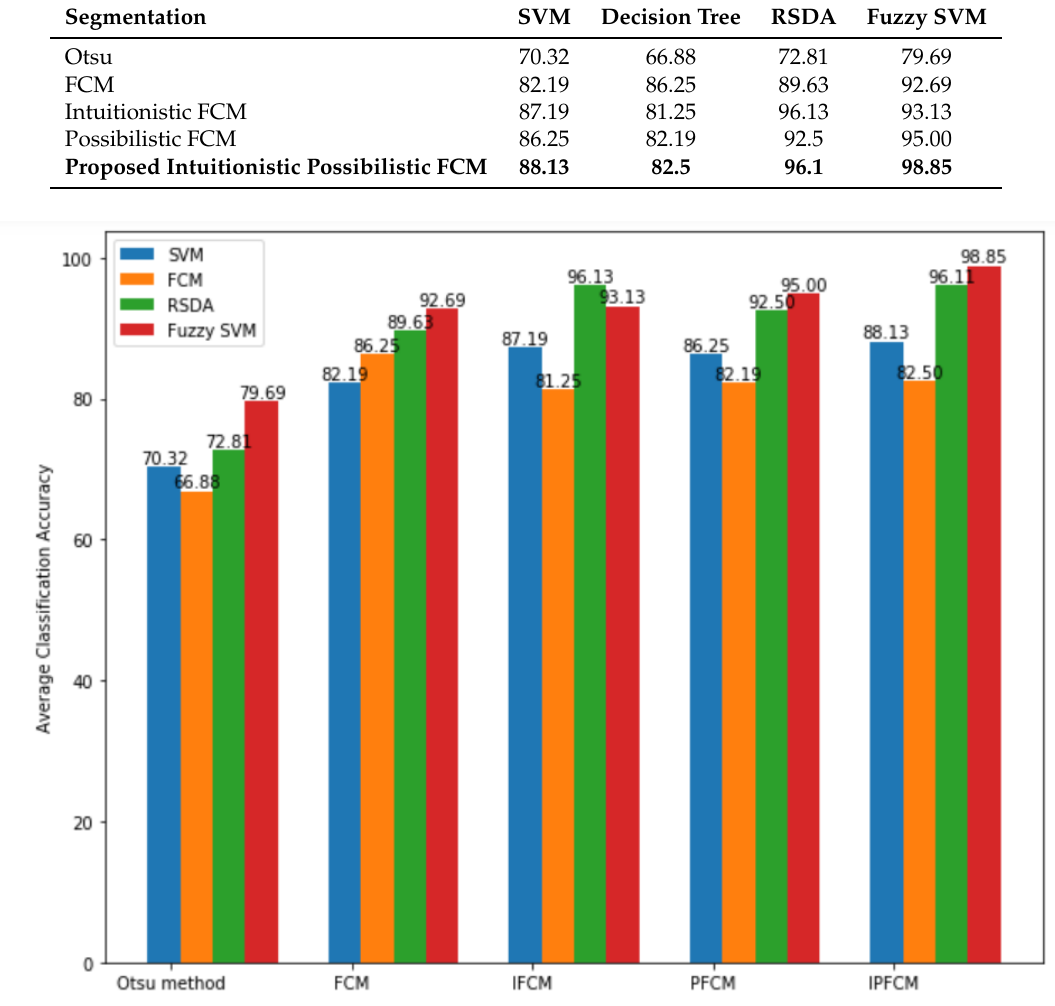
Table 6. Classification accuracy (Average) for five segmentation methods. Classification (All Features)